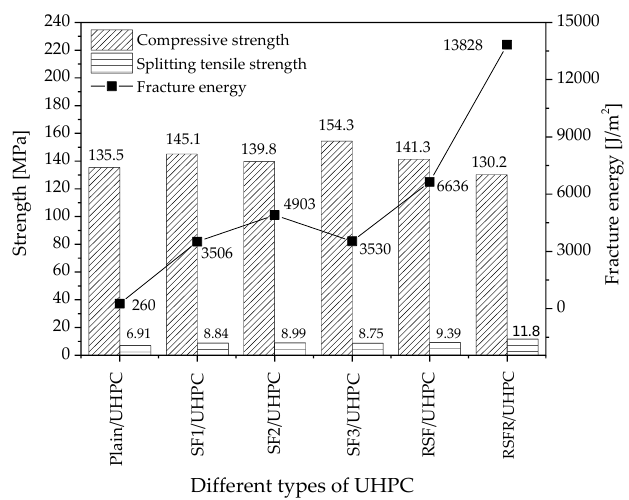
Figure 4. Compressive strengths, splitting tensile strengths, and fracture energies of UHPCs with various steel fibers and plain UHPC.